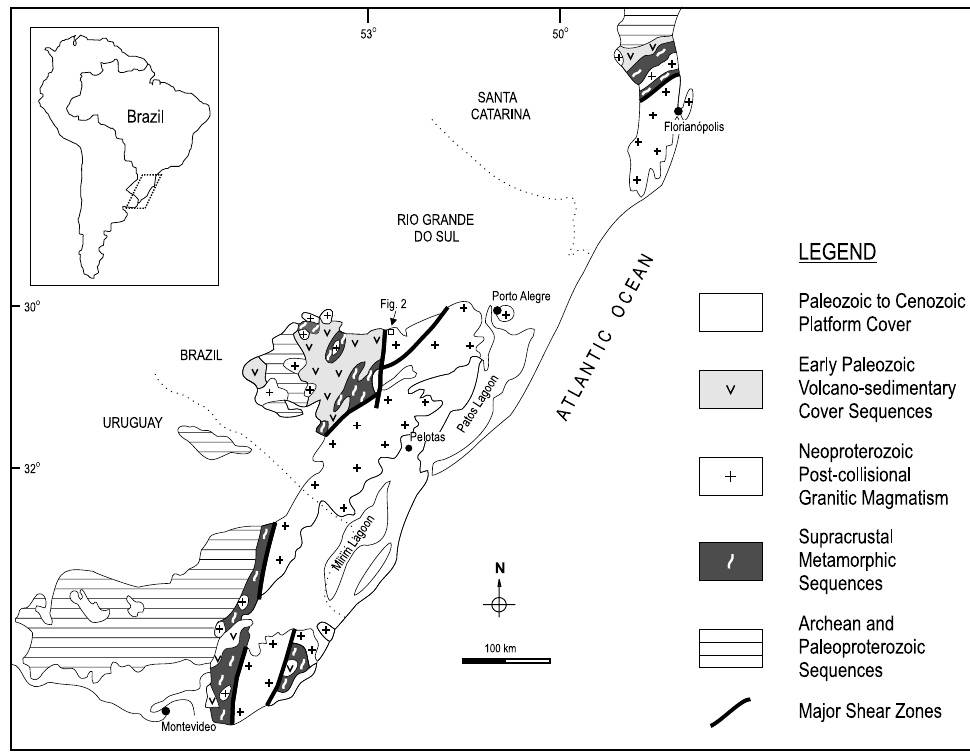
Fig. 1 – Geological context of southernmost